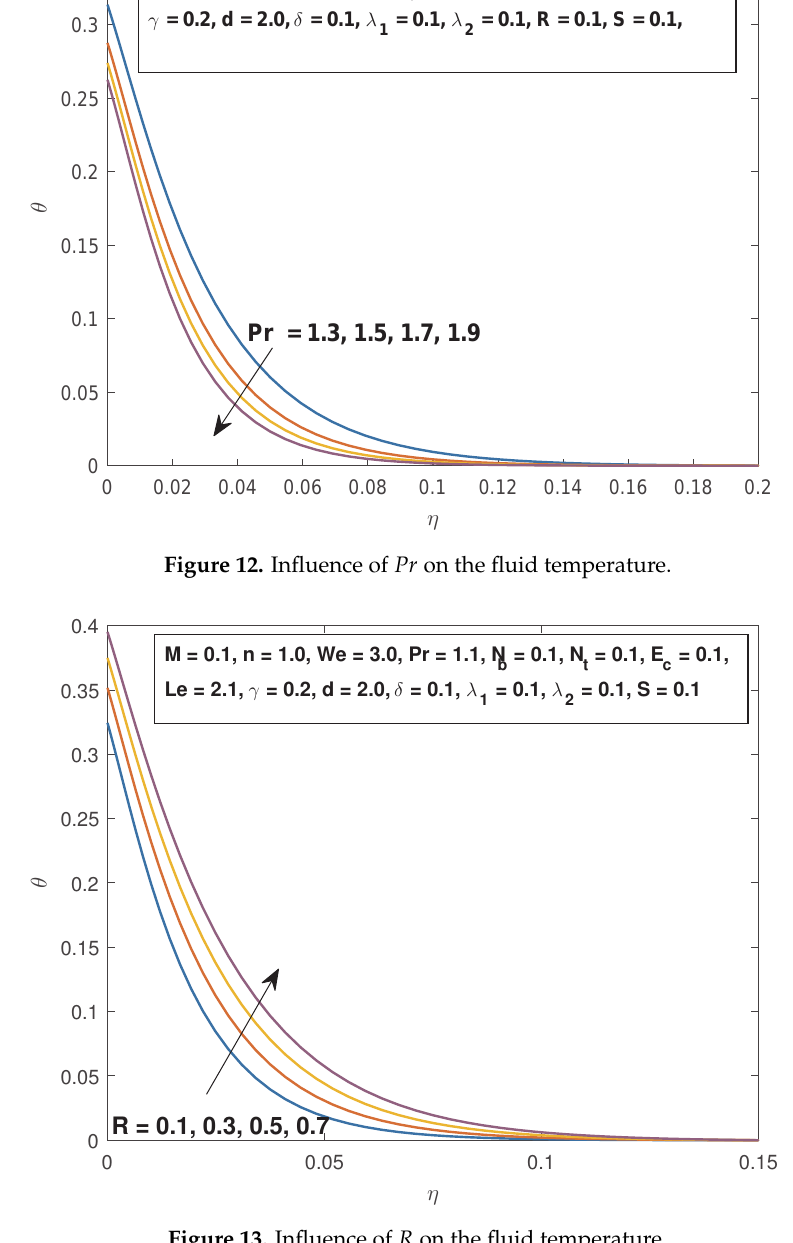
Figure 13. Influence of R on the fluid